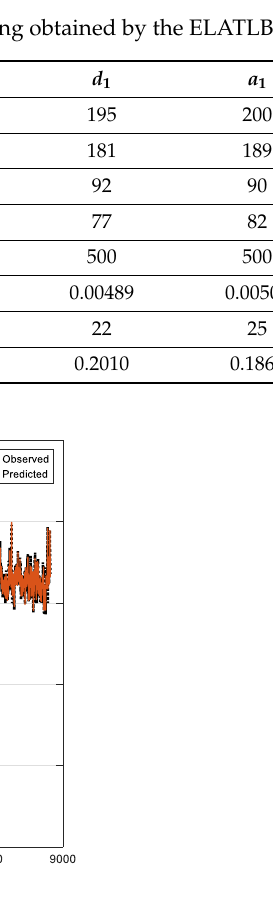
Figure 6. Minimizing validation RMSE of the a 1 forecasting model. Table 2. Optimal hyperparameters of LSTM for demand forecasting obtained by the ELATLBO.